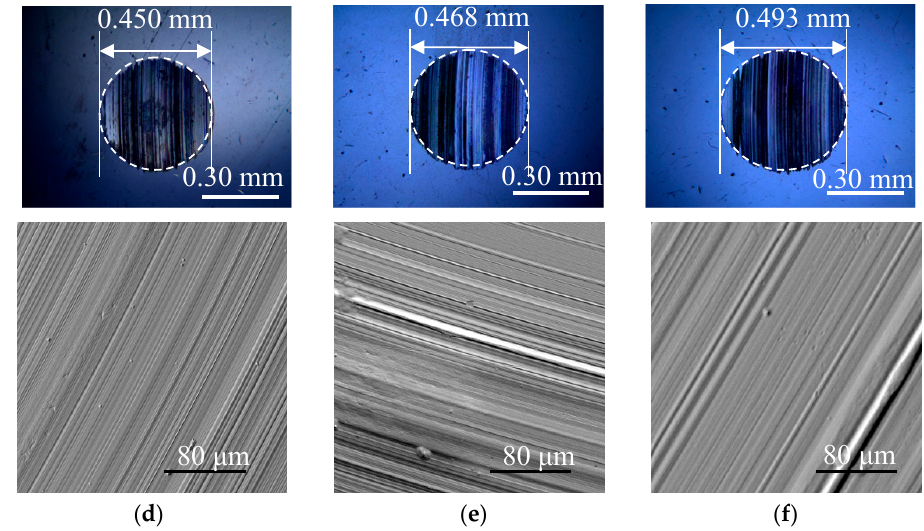
Figure 10. Scanning electron micrographs of abrasion scars from ( a ) pure oil; ( b ) 0.1 wt % WS 2 -CS; ( c ) 0.15 wt % WS 2 -CS; ( d ) 0.2 wt % WS 2 -CS; ( e ) 0.3 wt % WS 2 -CS, and ( f ) 0.5 wt % WS 2 -CS.